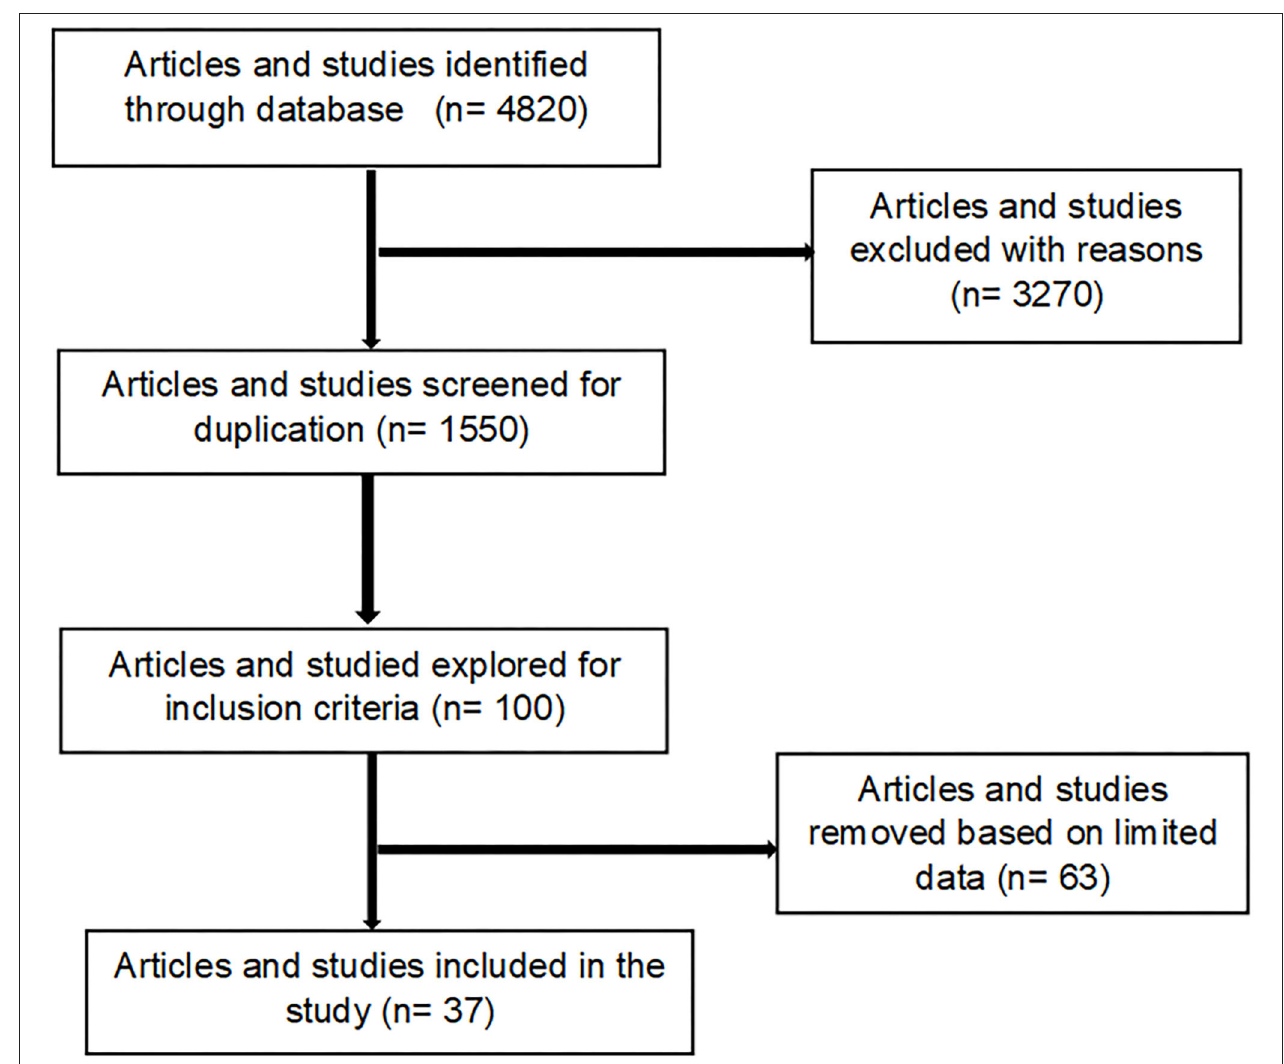
FIGURE 1 | Process used for the selection of articles included in the generated inventory ( Supplementary Table S1